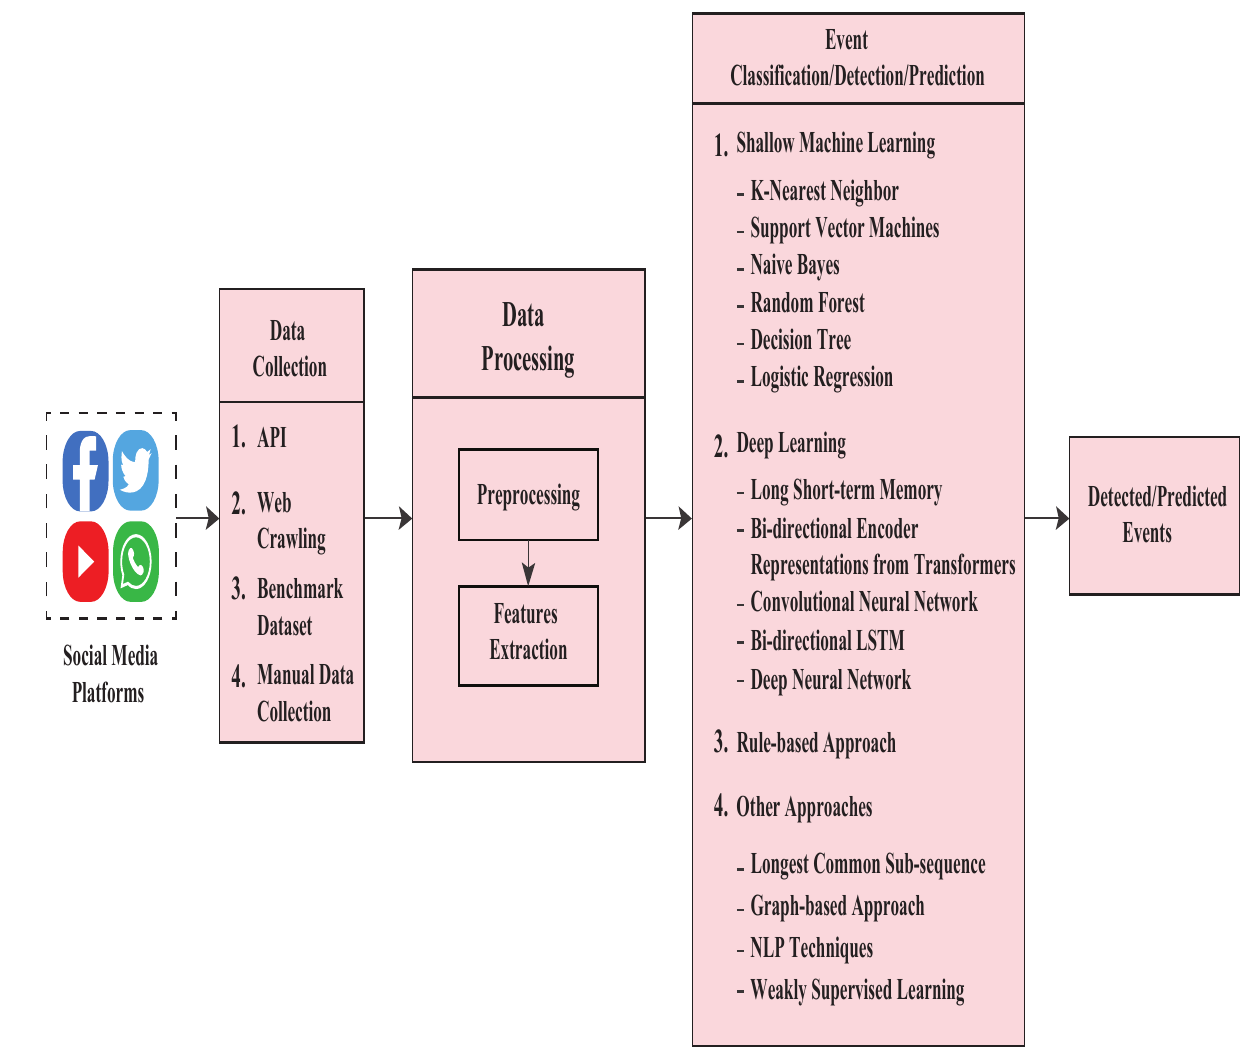
Figure 2. A generic approach illustrating the phases to identify events by employing social media